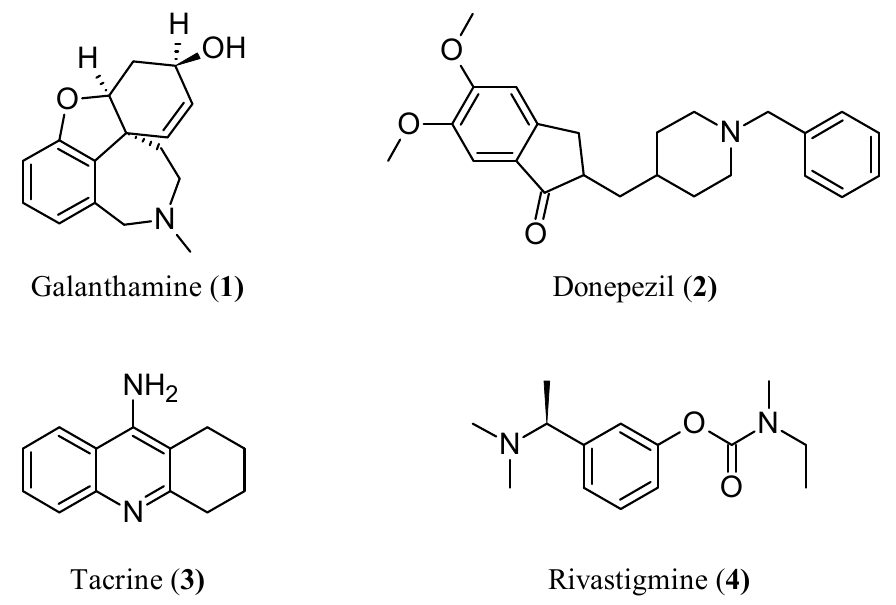
Figure 1. AChE inhibitors currently used in therapeutics to